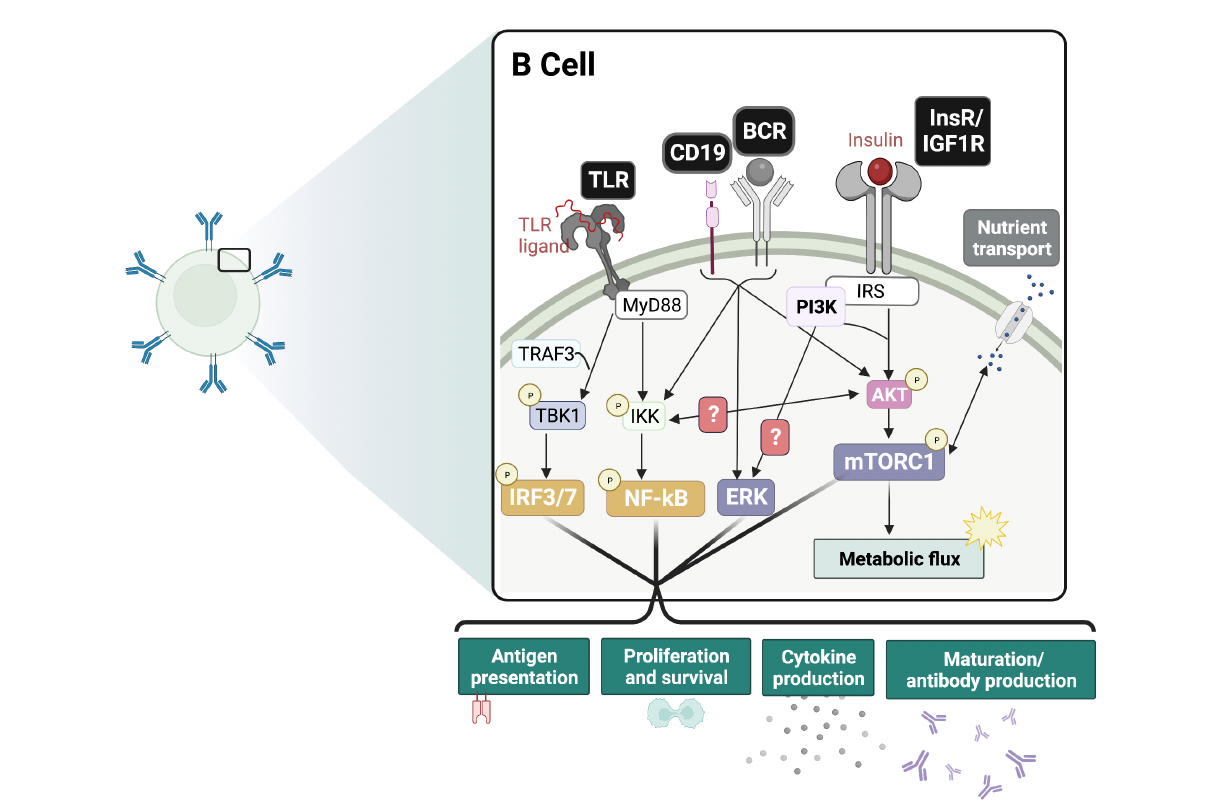
FIGURE 2 Insulin signaling functions as an adjuvant of B cell responses. Proposed crosstalk between InsR and BCR/CD19 and PRR signaling pathways. In the presence of antigen-BCR mediated ERK signaling and TLR-ligand mediated IRF and NF-kB signaling, the additive effect of InsR/IGF1 signaling is expected to drive in fl ammatory responses. This includes boosting glycolysis and nutrient transport, as well as maturation and antibody production, cytokine production, antigen presentation and proliferation. BCR, B cell receptor; TLR, Toll-like receptor; InsR, Insulin receptor; IGF1R, Insulin-like growth factor 1 receptor; mTORC1, mammalian target of rapamycin complex 1; ERK, extracellular regulated kinase; IRF, interferon regulatory factor; NF-kB, Nuclear factor kappa